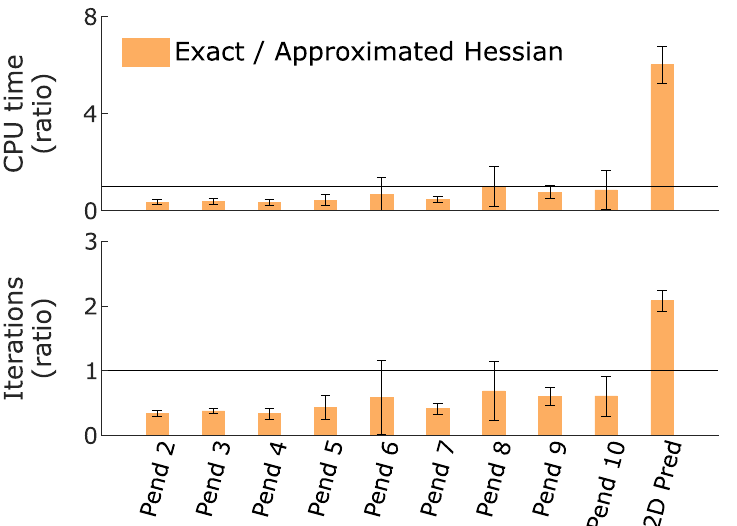
Fig 4. Comparison of computational time (top) and number of iterations (bottom) between exact and approximated Hessian. The comparisons are expressed as ratios and averaged over results from different initial guesses (error bars represent ± one standard deviation). The horizontal lines indicate 1:1 ratios. Ratios larger than one indicate slower convergence (top) and more iterations (bottom) with an exact versus an approximated Hessian. Pend indicates pendulum simulations with the number being the number of degrees of freedom; Pred and Track indicate predictive and tracking simulations, respectively. The results were obtained using all solvers and AD-Recorder.